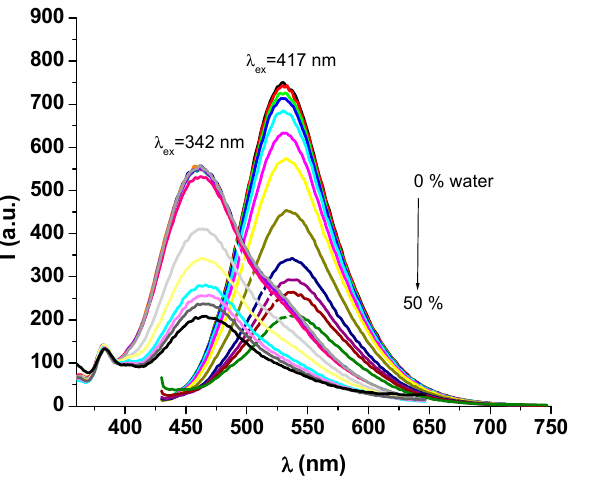
Figure 8. Fluorescence spectra of 8 in DMF adding different water levels ( λ ex = 420 nm, 342 nm).